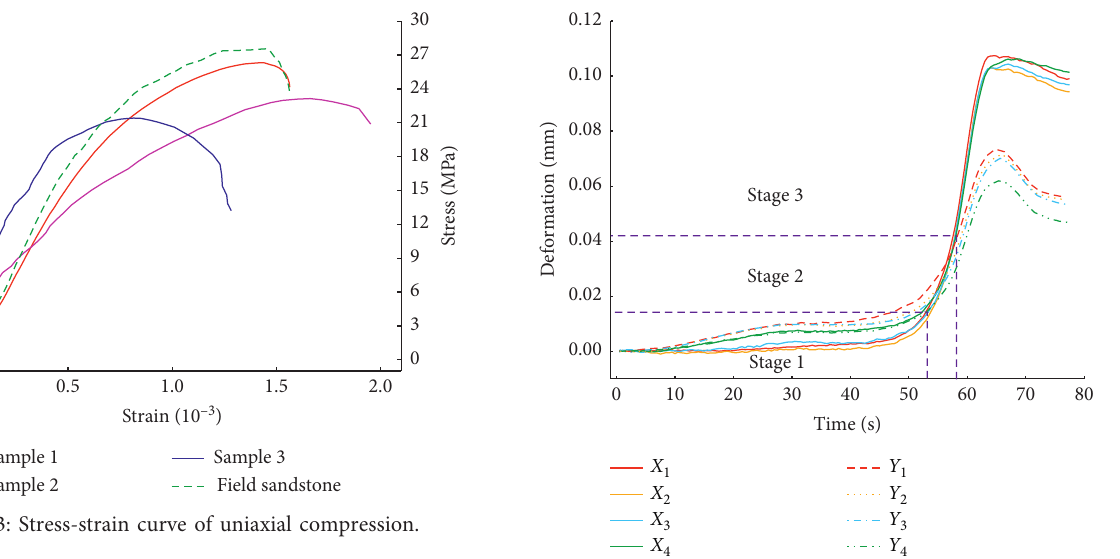
Figure 4: Displacement evolution of measuring point in SLB1.